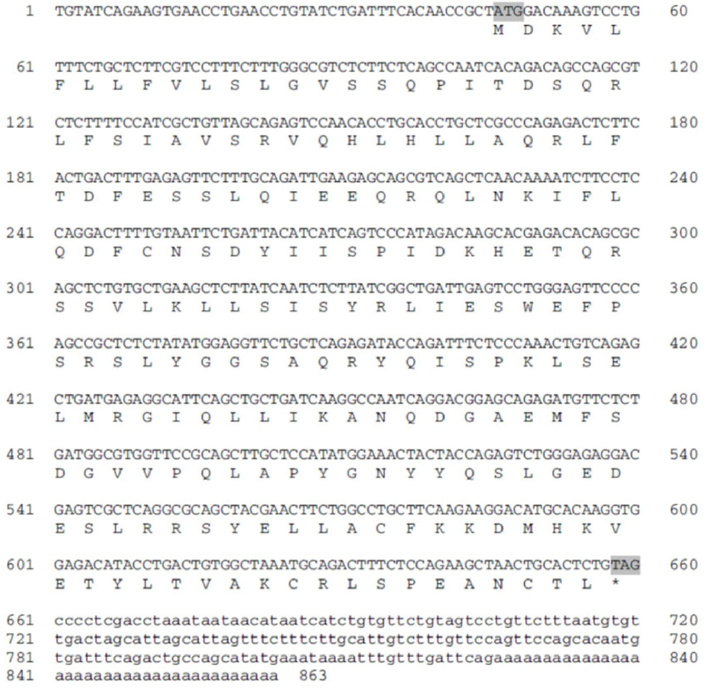
Figure 20. Nucleotide sequence of blue gourami growth hormone (GH) cDNA together with the hormone’s putative amino acid sequence (in three letter code) [42].